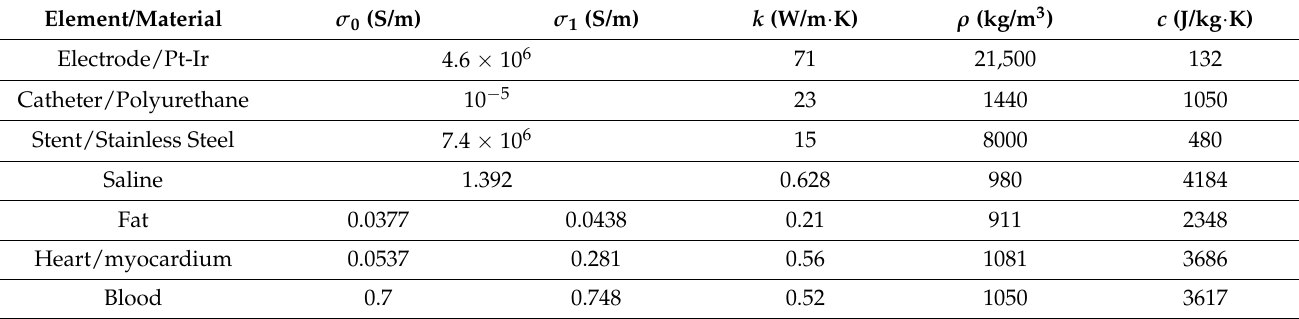
Table 1. Electrical and thermal properties of the model elements